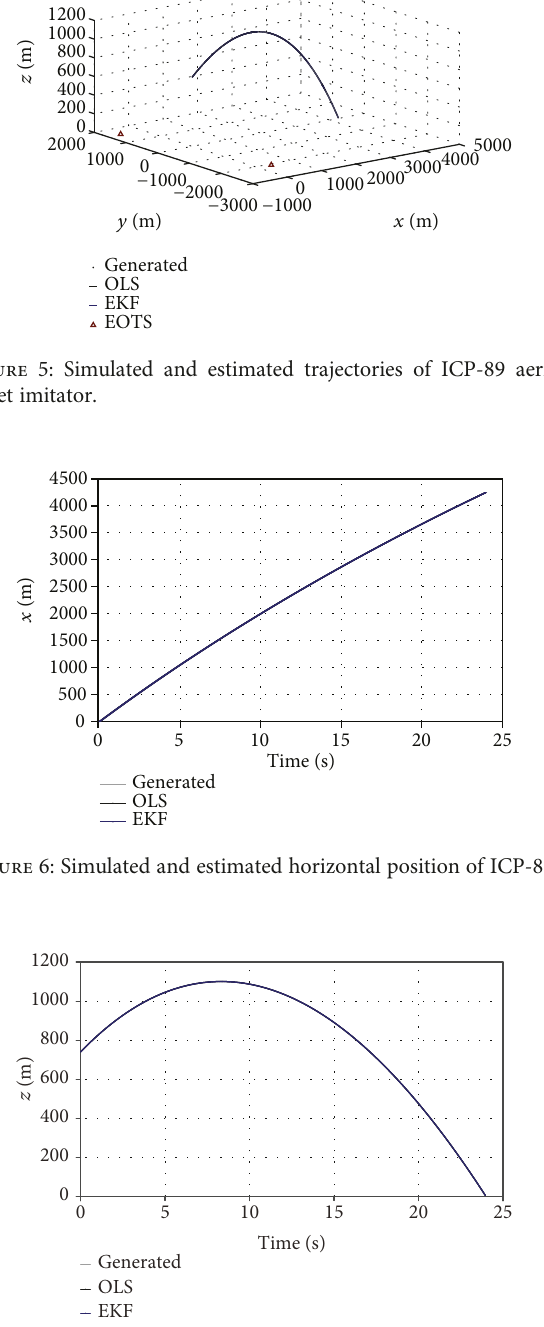
Figure 7: Simulated and estimated vertical position of ICP-89.